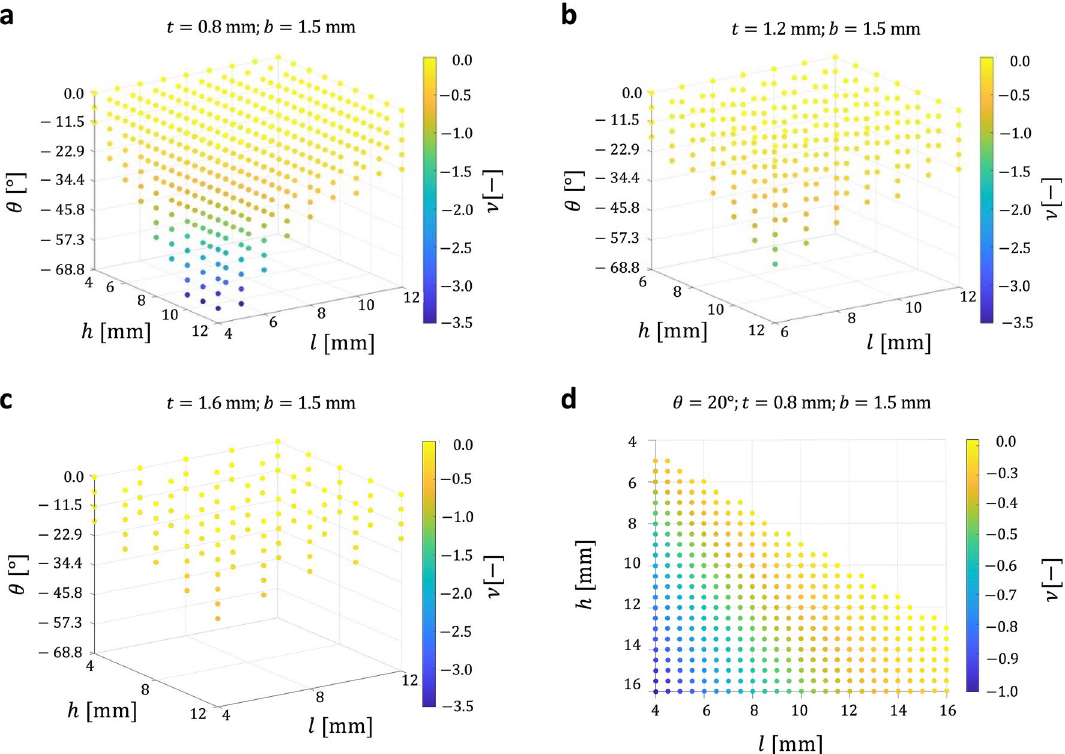
Figure 4. Scatterplots used to analyze the effect of the geometrical parameters θ , h , and l on the Poisson’s ratio ν , based on the analytical equation [Eq. (1), considering K hg as hinging force constant], for fixed values of global the t and b parameters, i.e., t = 0.8mm and b = 1.5mm ( a ), t = 1.2mm and b = 1.5mm ( b ), t = 1.6mm and b = 1.5mm ( c ), and for fixed values of θ , t and b parameters ( d , θ = 20 ◦ ; t = 0.8mm ; b = 1.5mm